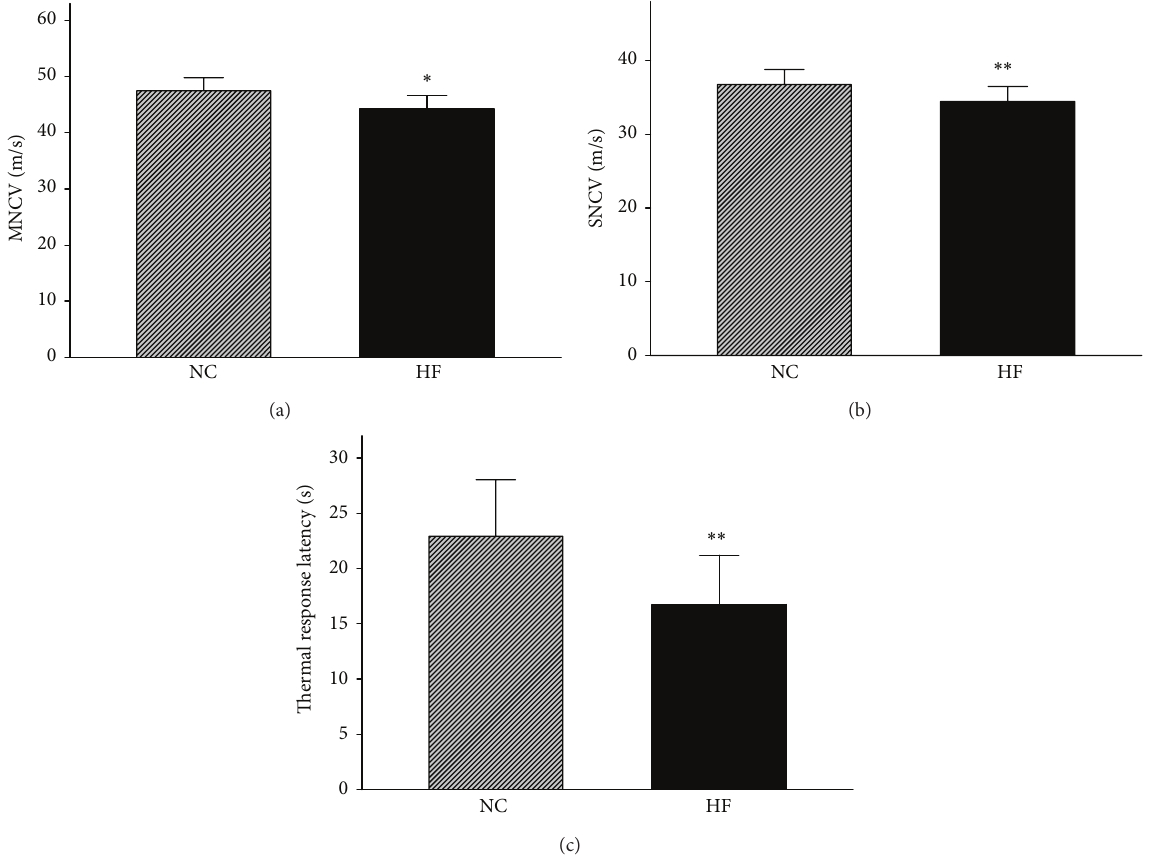
Figure 2: Motor nerve conduction velocity (a), sensory nerve conduction velocity (b), and thermal response latency (c). NC and HF, abbreviations for “normal diet” and “high-fat diet,” represent the control and HFD-fed groups, respectively. Data are presented as the mean ± SE, 𝑛 = 15 mice/group, ∗ 𝑃 < 0.05 , and ∗∗ 𝑃 < 0.01